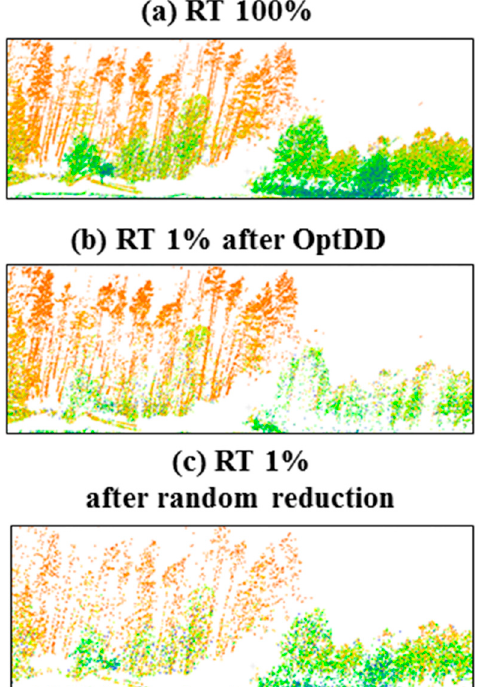
Figure 13. RT after reduction: ( a ) original, ( b ) RT after OptD method, ( c ) RT after random reduction.